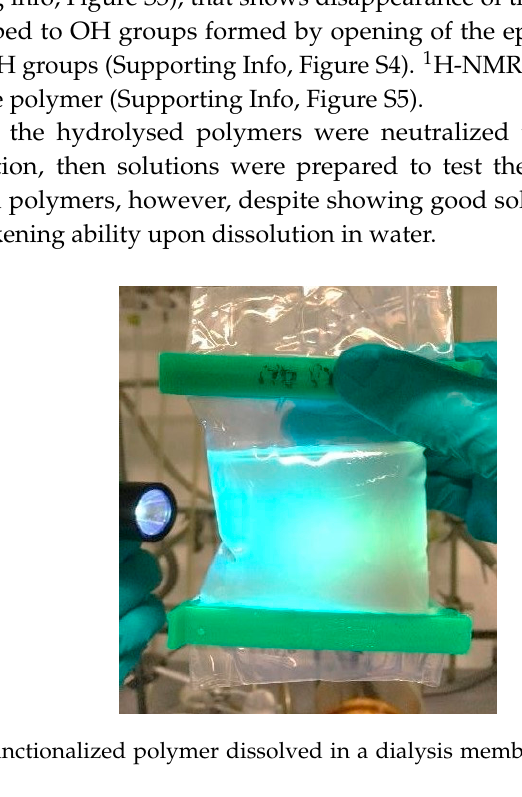
Figure 10. Relative resistance variation (%) of 7 wt.% MWCNTs/TP9PYR(6) dispersion as a function of ( a ) CHCl 3 and ( b ) THF vapours concentration (ppm).